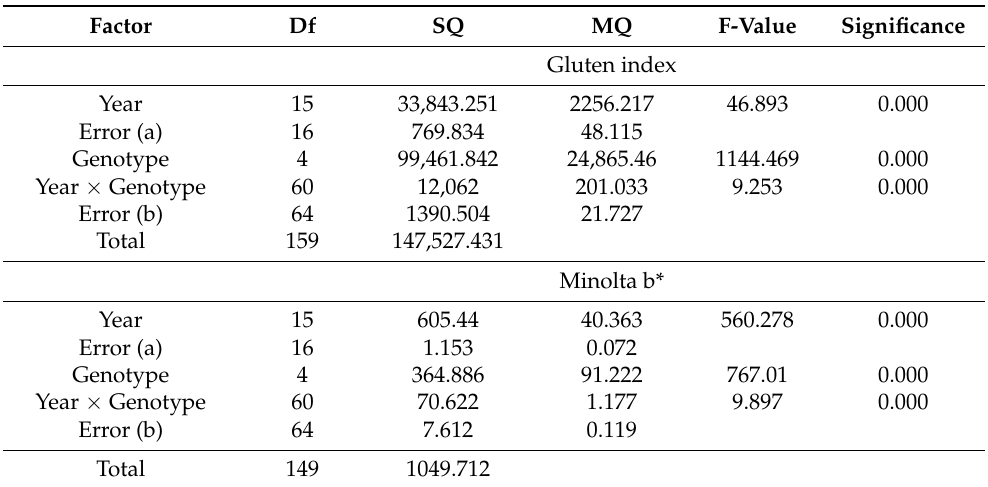
Table 1. Analysis of variance of gluten index and Minolta b* values for five winter durum wheat cultivars in